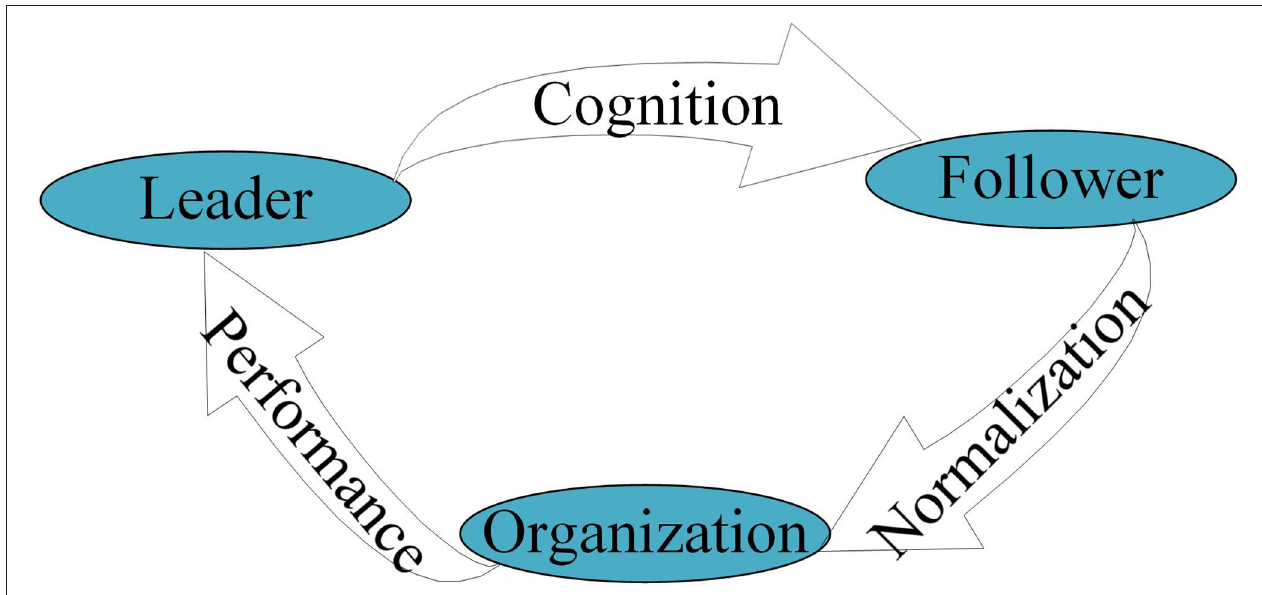
FIGURE 1 | Leadership ontology Cognition–Normalization–Performance